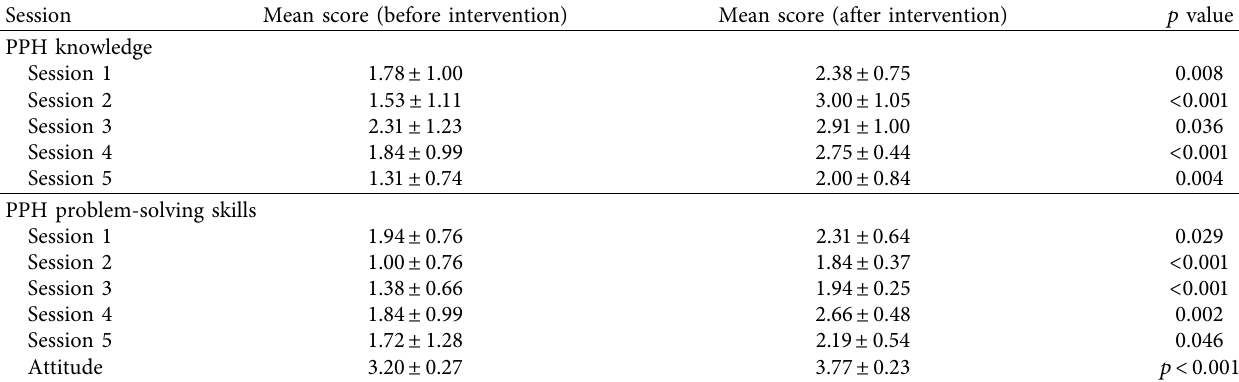
Table 1: Changes in the level of the midwives’ PPH knowledge and problem-solving skills in different sessions of the electronic CME ( n � 32).